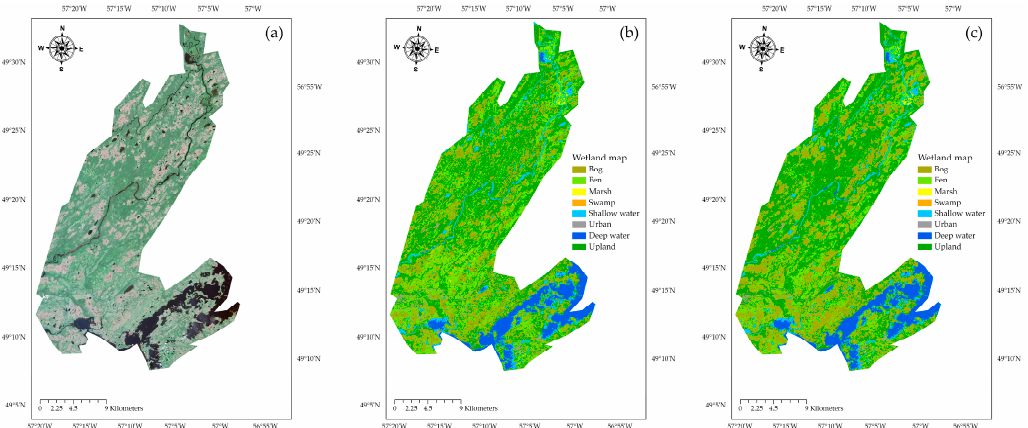
Figure 12. ( a ) A true color composite of RapidEye optical imagery (bands 3, 2, and 1) acquire on June 18, 2015. The classification maps of the Deer Lake study area obtained from ( b ) FP (OA: 84.75%, K: 0.81) and ( c ) simulated CP SAR data (OA: 80.67%, K: 0.77).